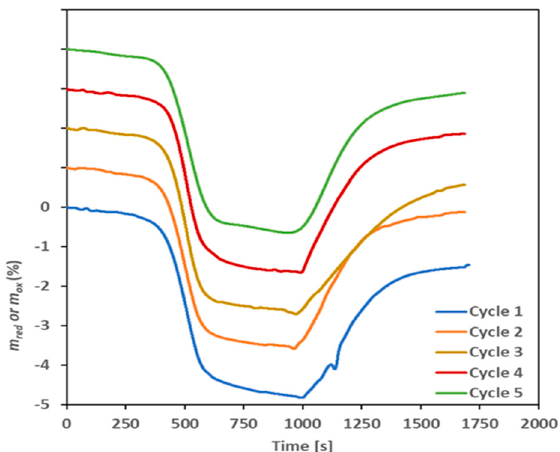
Figure 7. The reactivities of the Cu-OC with coal char m red in Ar and m oc in air of five cycles versus time at 900 °C in a TGA-QMS.